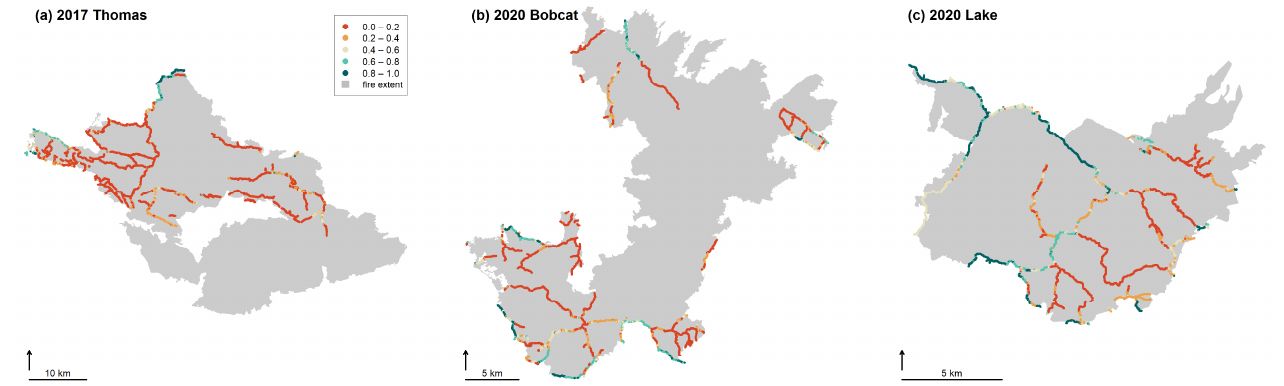
Figure 7. Predicted probability of fuel break success overlaid on the final fire footprints for the ( a ) 2017 Thomas, ( b ) 2020 Bobcat, and ( c ) 2020 Lake Fires from Model 2, constructed by iteratively withholding each fire from the training data (cross-validation by